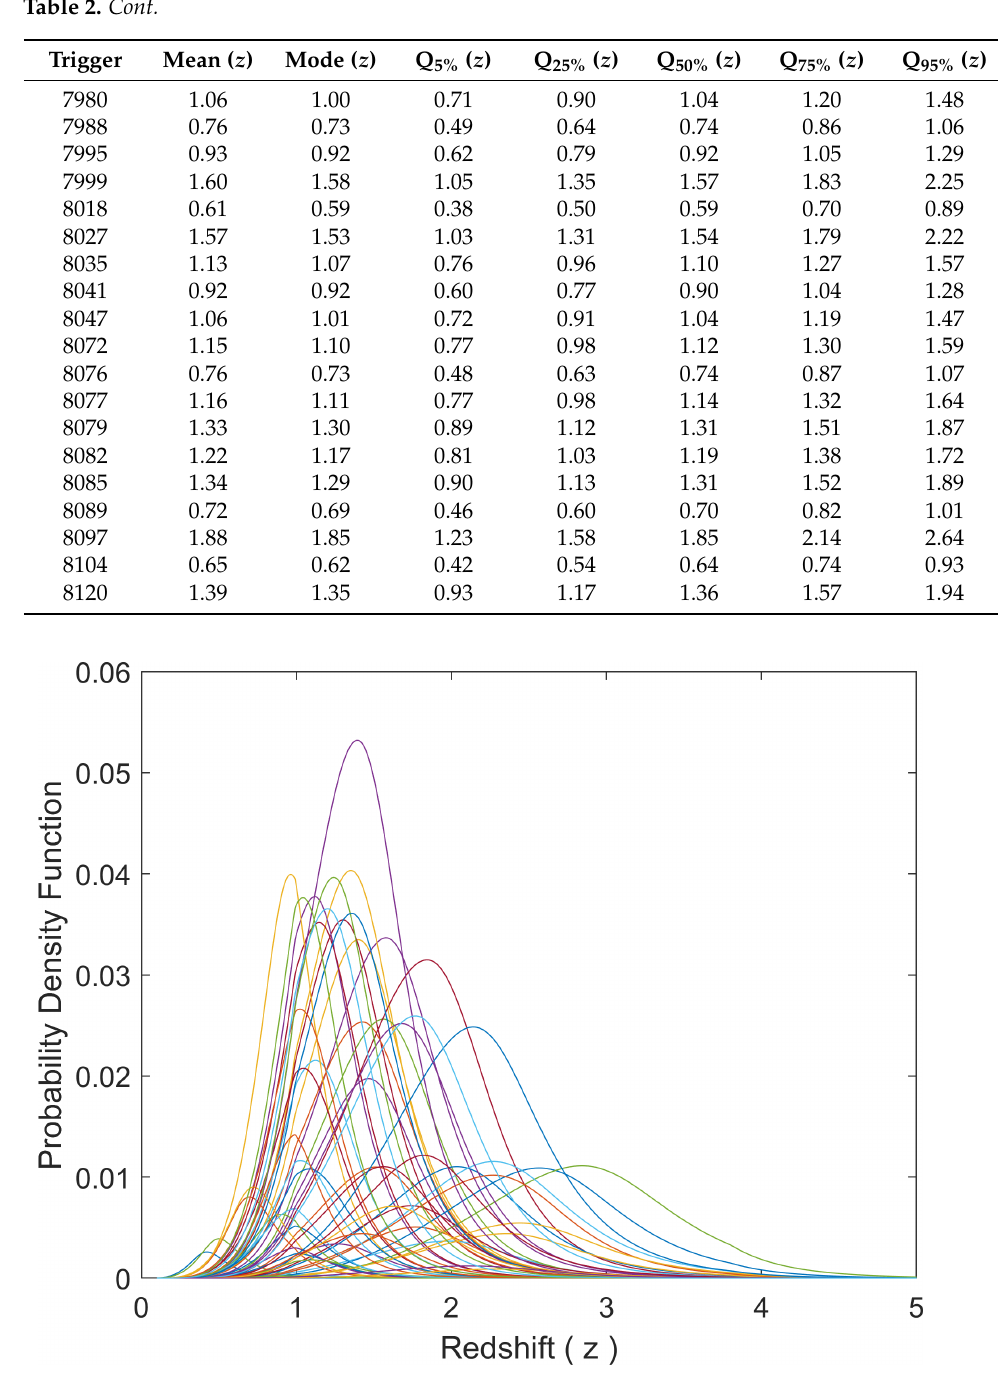
Figure 5. An illustration of the derived probability density functions (PDFs) of the individual redshifts of a subset of 565 BATSE SGRBs. Each curve corresponds to the inferred likelihood of different values of redshifts (z) for a single BATSE